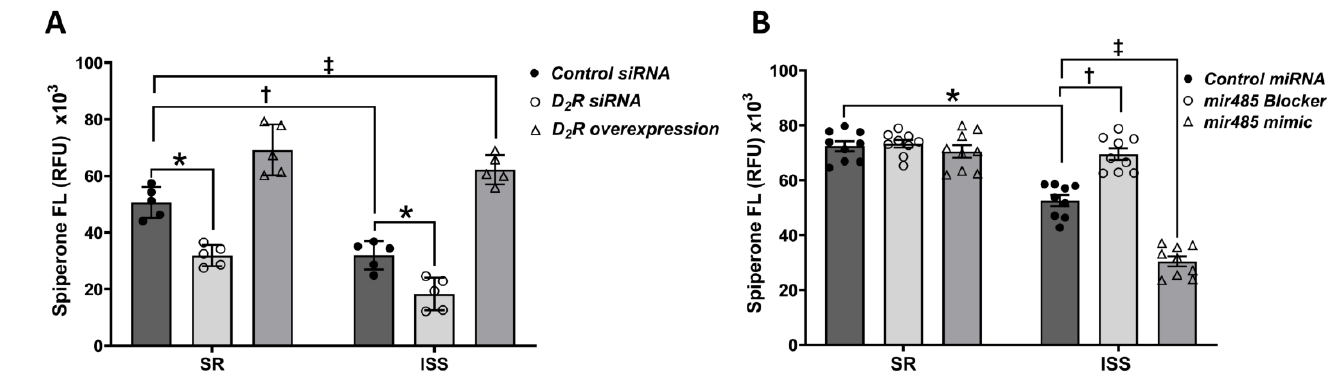
Figure 5. D 2 R cell surface expression when knocked down, overexpressed, or blocked in cells from subjects with SR or ISS. ( A ) siRNA decreases D 2 R cell surface expression in uRPTCs from both SR and ISS subjects (37.1% ± 2.0% reduction in SR DRD2 siRNA vs. SR control, n = 5, and 42.7% ± 6.0% reduction in ISS DRD2 siRNA vs. ISS control, n = 5, *, †, p < 0.01, Two-way ANOVA, Tukey’s test). The overexpression of D 2 R is relatively greater in uRPTCs from ISS than SR (22.5% ± 0.9% increase for ISS D 2 R overexpression over SR control siRNA, n = 5, ‡ p < 0.01, Two-way ANOVA, Tukey’s test). ( B ) mir-485-5p is involved in the reduced expression of the D 2 R in uRPTCs from individuals with ISS and DRD2 rs6276 because mir-485 blocker normalizes DRD2 expression in these cells (52619 ± 2001 RFU ISS control miRNA vs. 69,496 ± 2108 RFU ISS miRNA blocker and vs. 30,434 ± 1824 RFU ISS miRNA mimic, n = 9, Two-way ANOVA, Tukey’s test, *, †, ‡, p < 0.01); there is no effect in uRPTCs from individuals with SR. Mir-485 mimic decreases spiperone binding in uRPTCs from individuals with ISS and DRD2 rs6276; there is no effect in uRPTCs from individuals with SR. ISS = inverse salt-sensitive; SR = salt-resistant.